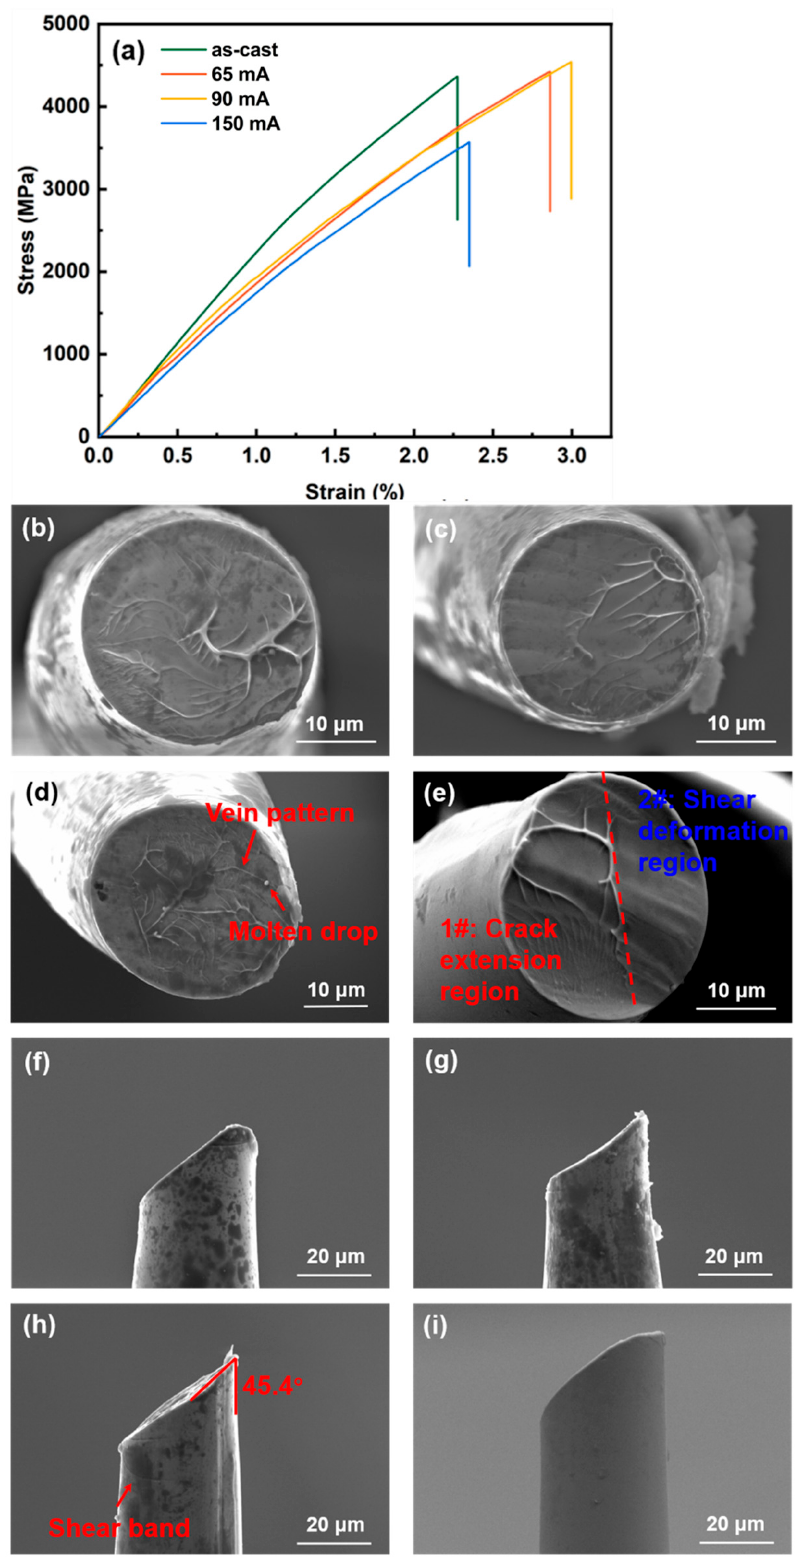
Figure 5. ( a ) Stress–strain curves of as-cast and direct current-annealed Co-based metallic microwires. Fracture morphology of as-cast and direct current-annealed Co-based metallic microwires: ( b ) Front view, as-cast; ( c ) Front view, 65 mA; ( d ) Front view, 90 mA; ( e ) Front view, 150 mA; ( f ) Side view, as-cast; ( g ) Side view, 65 mA; ( h ) Side view, 90 mA; ( i ) Side view, 150 mA.